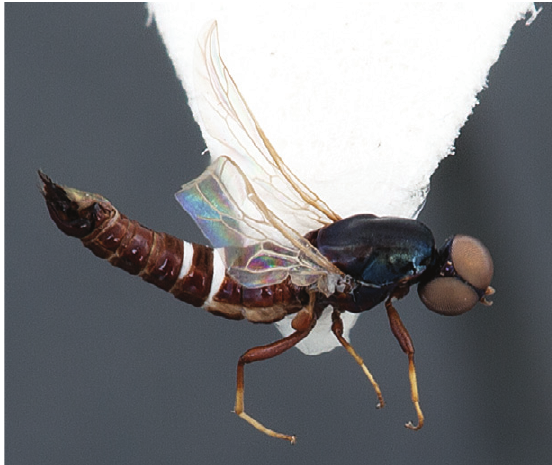
Figure 1. Prepseudatrichia tiger sp. n.: Male holotype habitus. Body length= 4.1 mm. admixed with few short setae on outer surface of scape and pedicel, style subterminal; ocellar tubercle raised, broad; postocular ridge very narrow, with few minute setae laterally; occiput relatively flat to concave, pale pubescent medially; gena sparsely covered with fine yellowish setae. Thorax . Glossy brown-black with metallic irides- cence, scutum finely rugose to scrobiculate posteromedially, very sparsely overlain with short pale setae; postpronotal lobe and postalar ridge pale tan; pleuron smooth and polished, except for a few sparse fine setae; coxae and femora brown; tibia brown basally, dark-yellow apically; sparse, short setae on legs; haltere dark brown; wing hyaline; venation typical for genus, dark yellow. Abdomen . Glossy brown, cylindri- cal, glabrous; dorsal surface flattened with dark, alveolate texture resembling elongate honeycomb; intersegmental membranes and posterior margins of tergites 3–4 bright white; tergite 2 sensory setal region as two circular patches. Male genitalia (Fig. 2B– C). Epandrial lobes scoop-like, not enclosing gonocoxites, elongate setae apically,